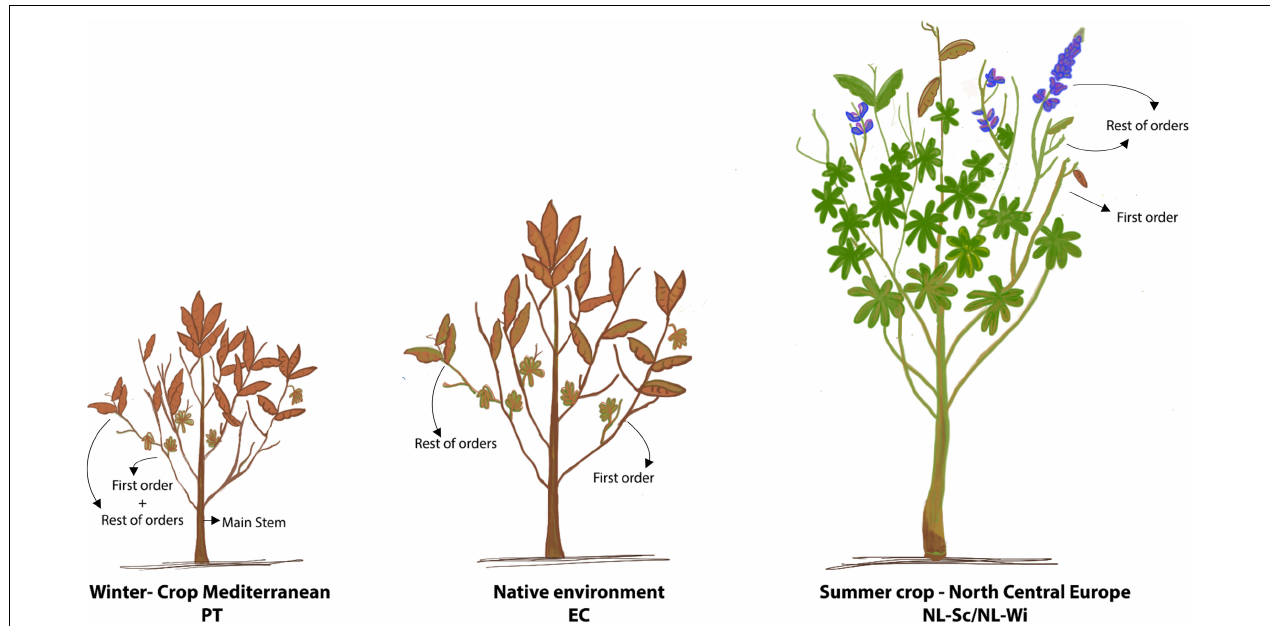
FIGURE 2 | Morphological development of Lupinus mutabilis in the tested environments. At harvest, in PT and EC, plants reached full maturity, were dry, and their architecture was generally restricted to two branching orders (semi-determinate growth habit). In NL, at harvest, plants were highly branched, still switching between vegetative and reproductive phases and therefore holding floral buds and pods often no economic value (indeterminate growth habit). In evidence, the different architectural parts of the plant are the main stem (MS), the first branching order (FO), and the rest of the branching orders (RO). In PT, production on the first order and the rest of the orders were scored